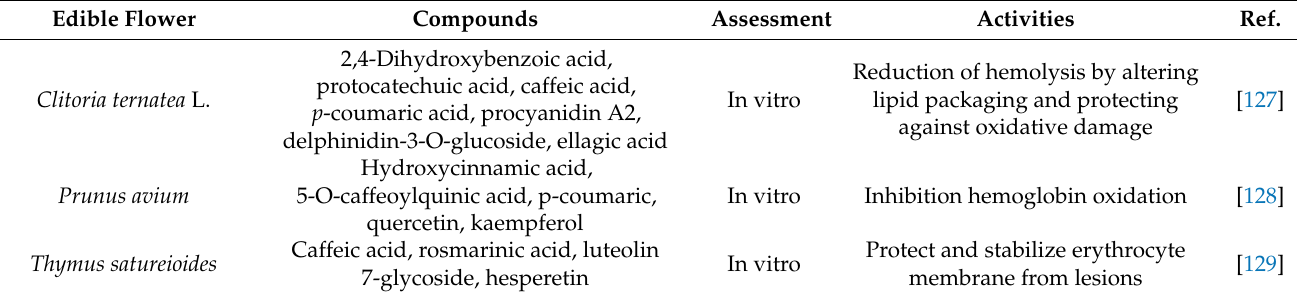
Table 9. Antihemolytic activities in edible